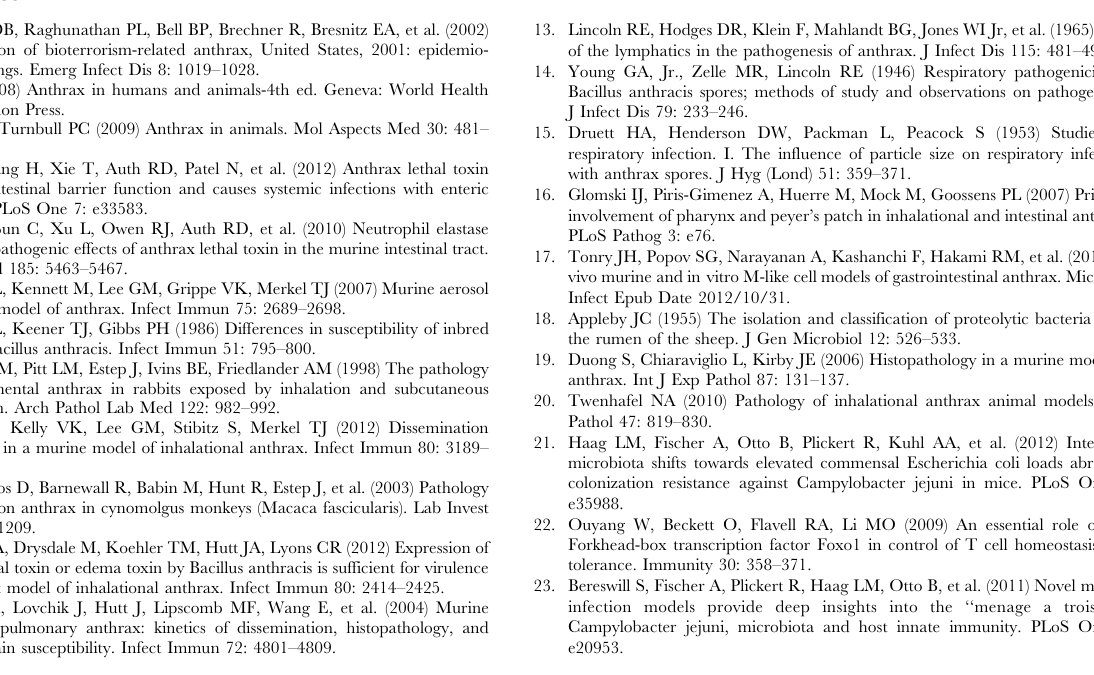
Figure S4 Intestinal anthrax infection does not increase inflammatory gene expression. Using RT-PCR, mRNA levels of the indicated pro-inflammatory genes were measured in jejunum samples obtained from mice 48 h following gavage with PBS (control, open bar,) or BaS (infected, closed bar). mRNA levels were first normalized to b -actin levels. Mean levels of each cytokine in PBS controls were arbitrarily assigned a relative level of 1 (n= 5/group; SEM values are